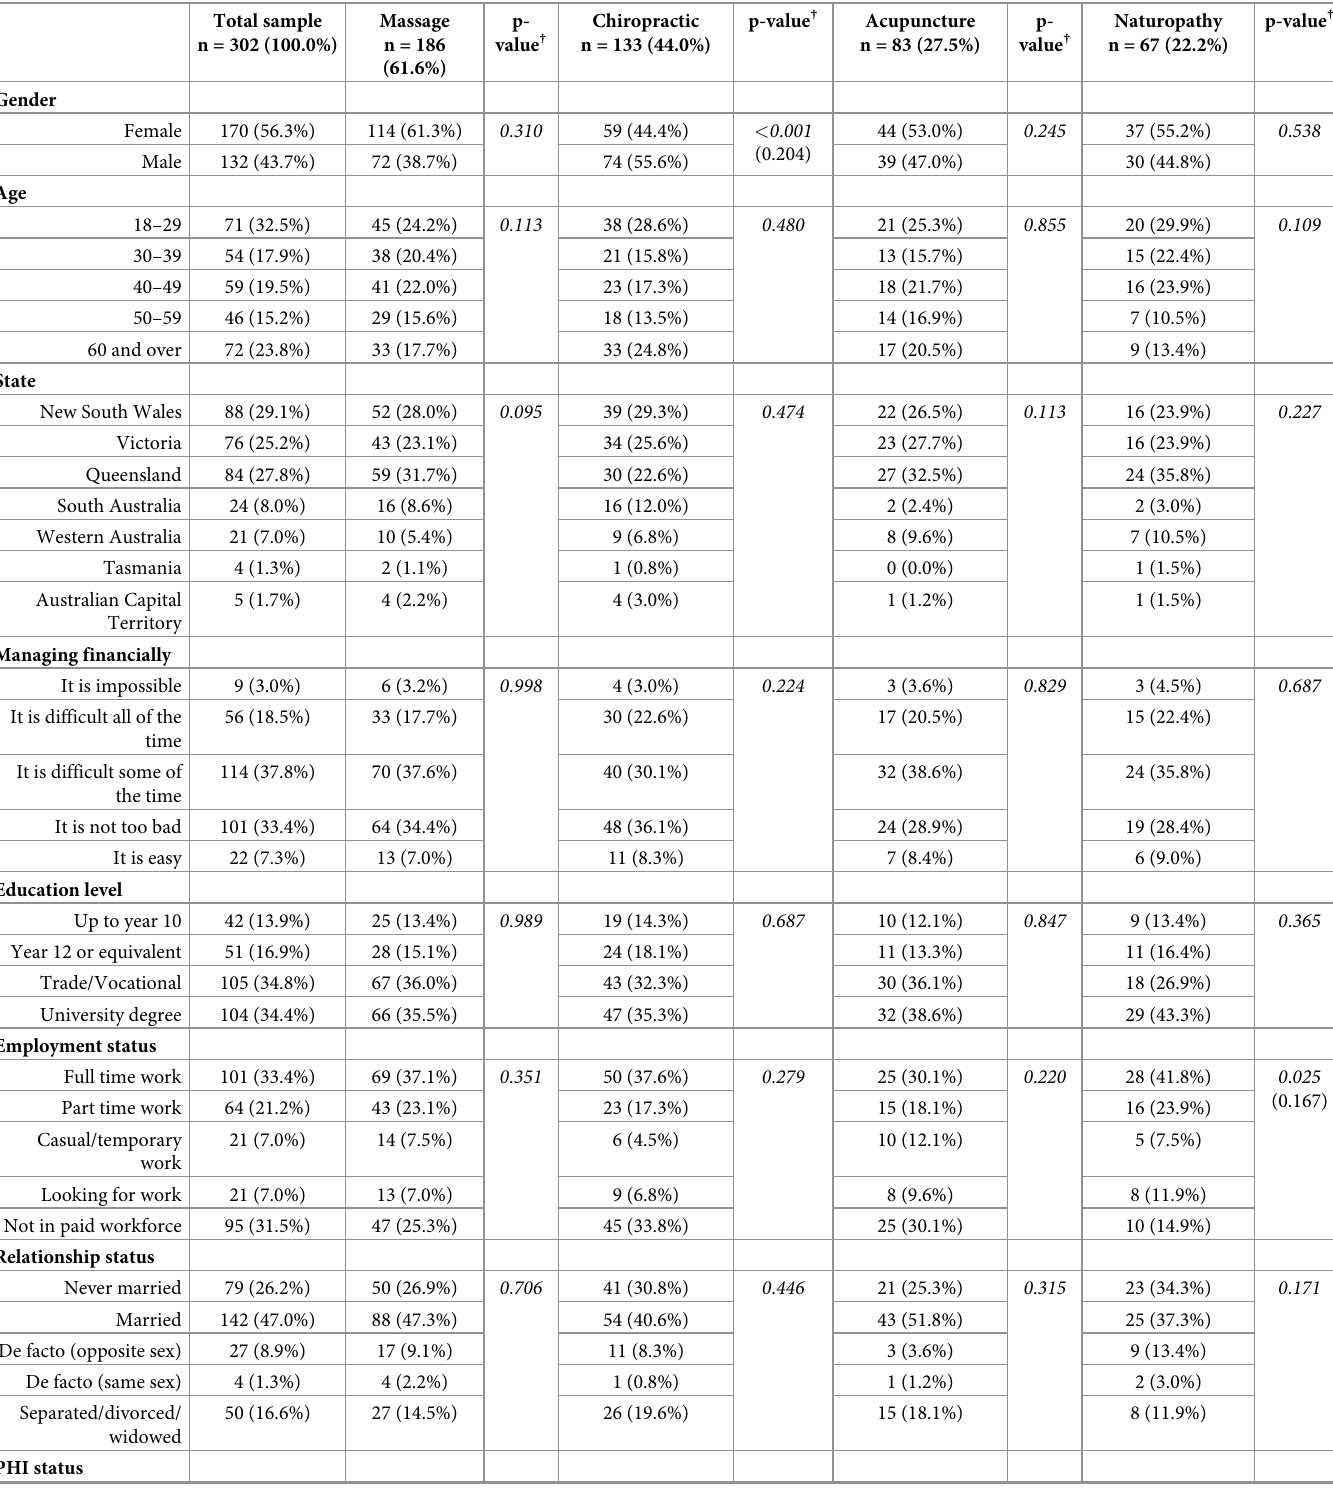
Table 1. Socio-demographic characteristics of participants and associations with complementary medicine professional